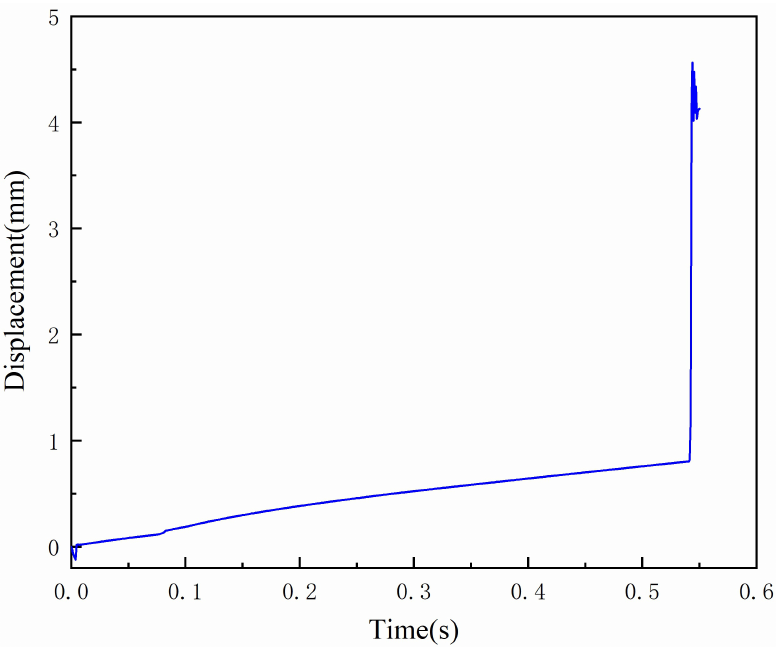
Figure 7. Axial displacement curve of the lock mechanism. The load is applied to the holdback bar front joint to simulate the aircraft catapult load on the holdback bar, as shown in Figure 8.